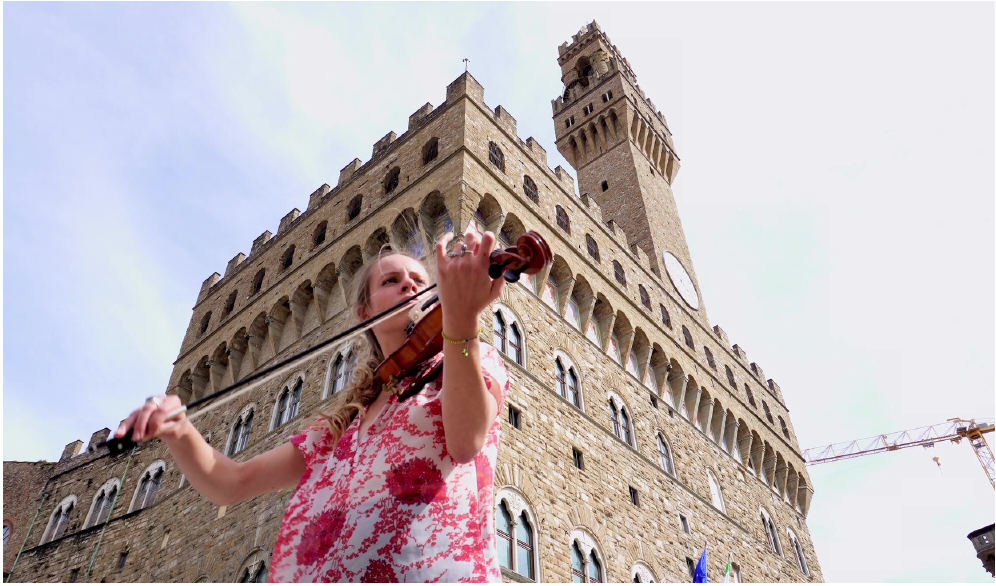
Fig. 7 The Violinist plays a melody inspired to Belgian traditional music, Piazza della